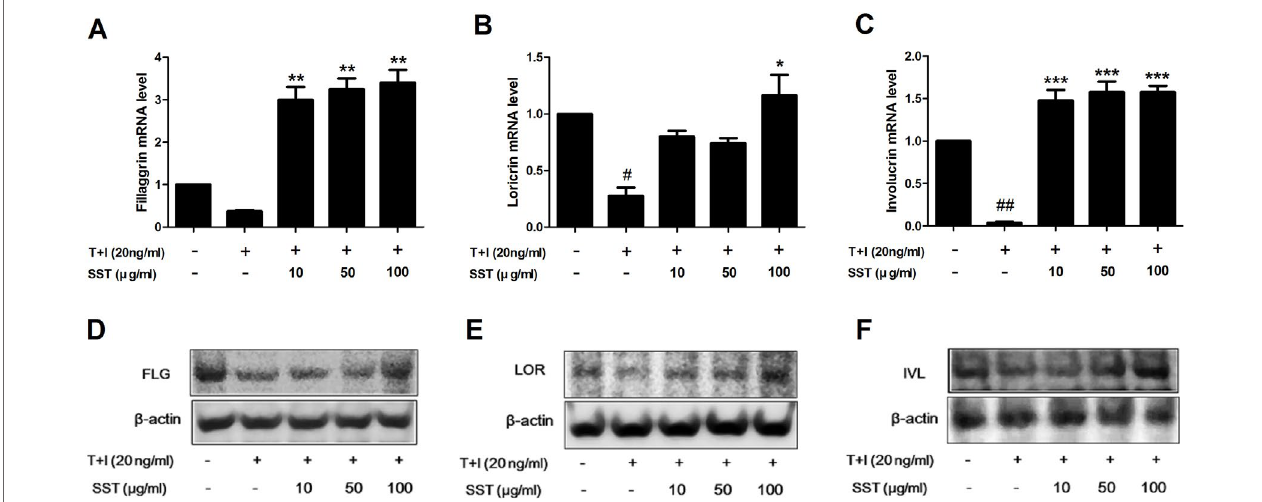
FIGURE 6 | Recovery effects of SST on skin barrier proteins in TNF- α /IFN- γ -treated HaCaT cells. HaCaT cells were pretreated with SST for 30 min and treated with TNF- α /IFN- γ for 24 h. The mRNA levels of filaggrin (FLG) (A) , loricrin (LOR) (B) , and involucrin (IVL) (C) were measured by real-time PCR. Cells were pretreated with SST for 30 min and treated with TNF- α /IFN- γ for 48 h. Protein levels of FIL (D) , LOR (E) , and IVL (F) were measured by western blotting. The data are shown as mean ± SEM of triplicate experiment. # p < 0.05, ## p < 0.01 vs. no-treatment condition, *p < 0.05, **p < 0.01, or ***p < 0.001 vs. only TNF- α /IFN- γ treatment